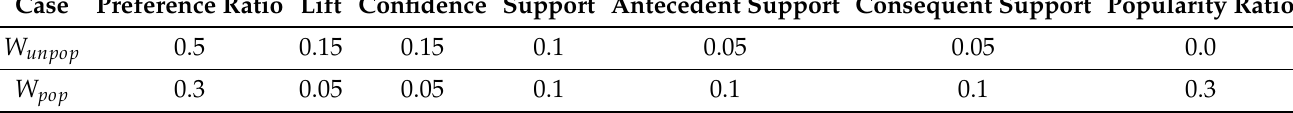
Table 5. Weights for different cases of